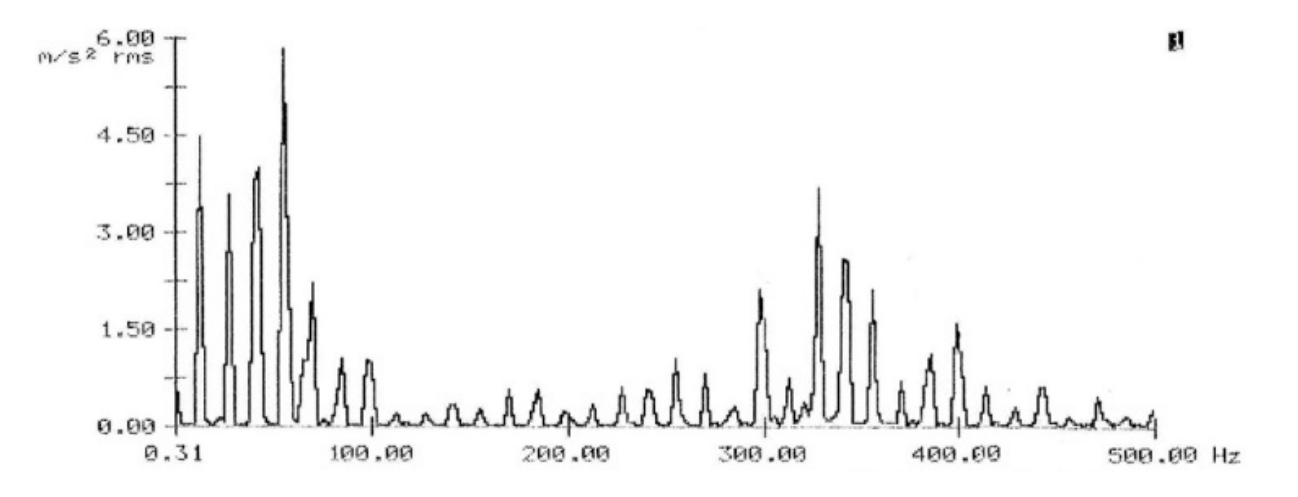
Figure 11. Synchronously averaged spectrum of the torsional vibration acceleration amplitude. Frequency range: 1–500 Hz.